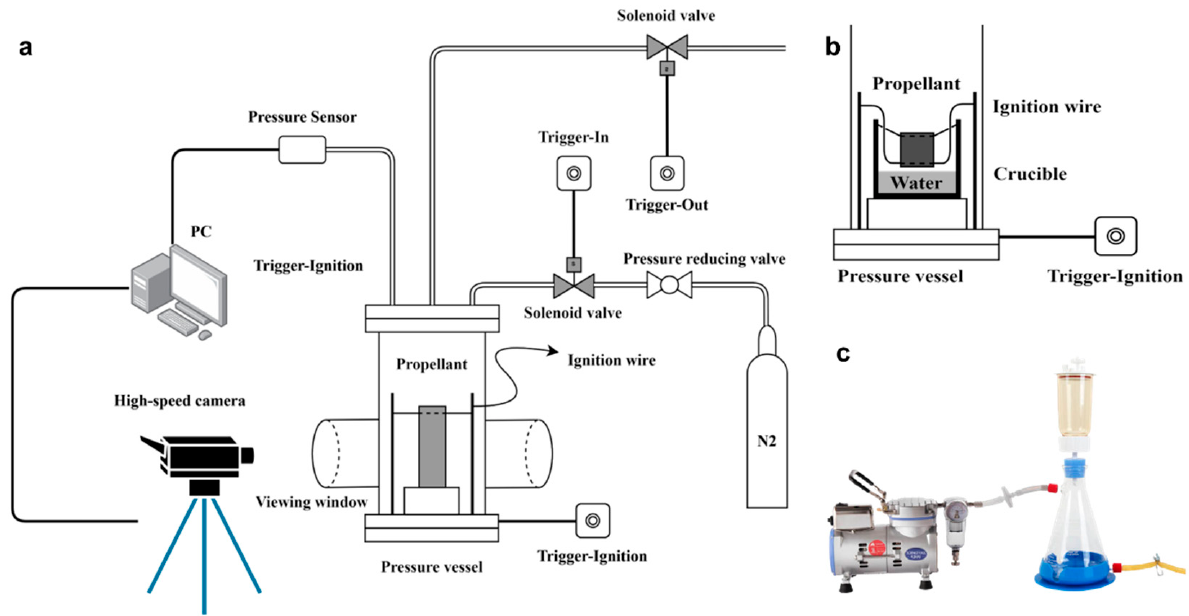
Figure 1. Schematic diagram of the experimental system: ( a ) Experimental system used for combus- tion surface agglomeration photography; ( b ) Combustion product collection device with cooling medium; ( c ) Vacuum filtration device.